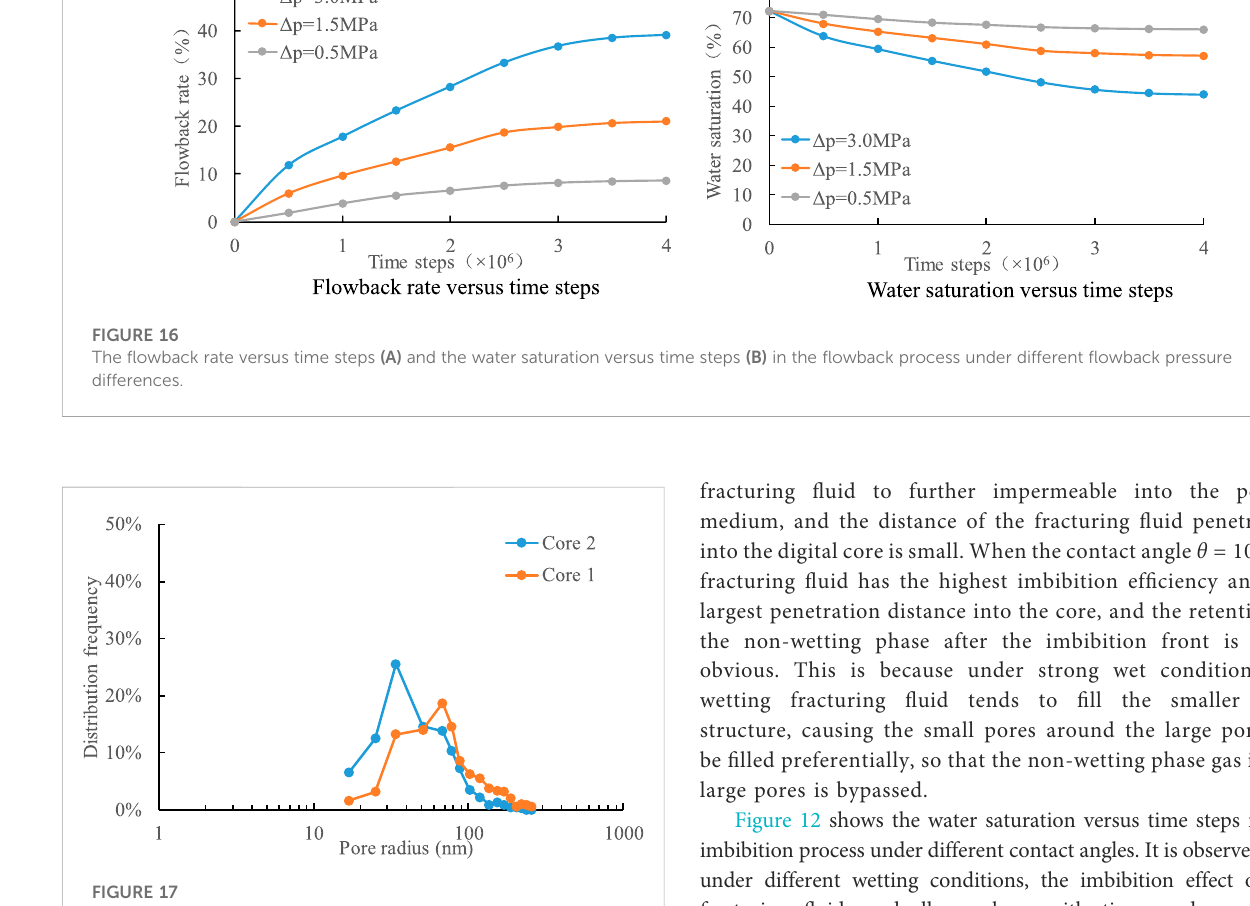
FIGURE 17 The pore size distribution of the two digital